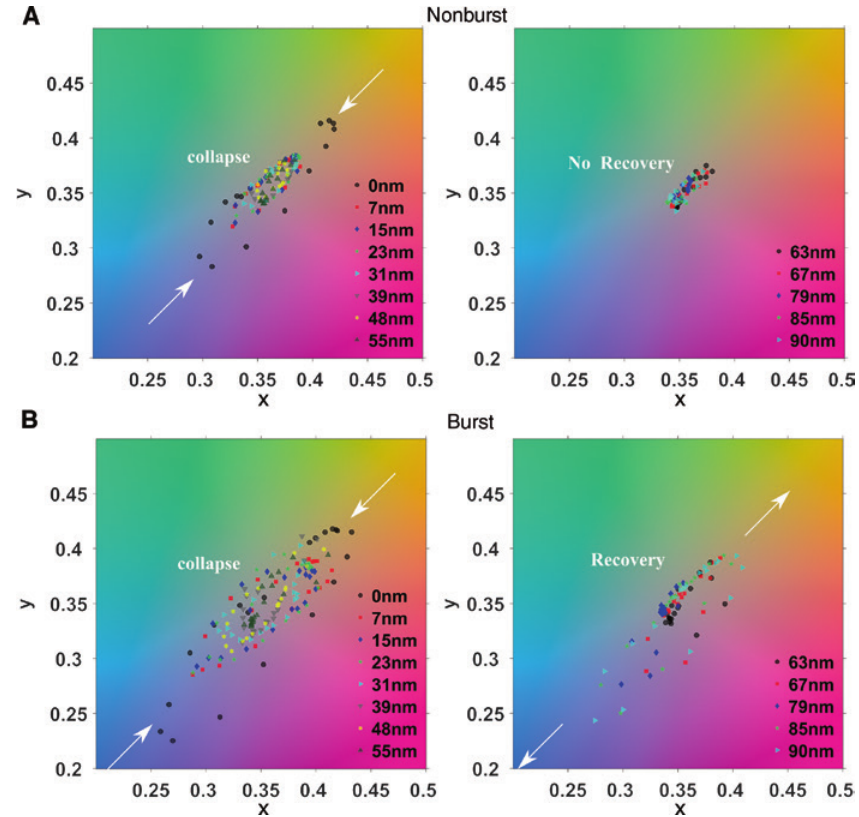
Figure 3: CIE of colours with increasing ALD thickness. CIE xy chromaticity diagrams showing the evolution of the (A) nonburst and (B) burst colours with increasing ALD thickness. The area on the CIE diagram spanned by the nonburst colours is observed to collapse with increasing alumina thickness. For the burst colours, the area spanned is observed to recover after 55 nm of alumina. The LCH values used in the CIE diagram were obtained by the unpolarised light source of the